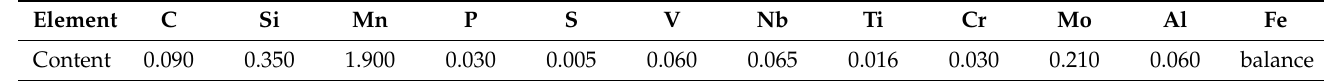
Table 1. Chemical composition of X80 pipeline steel ( ω / w